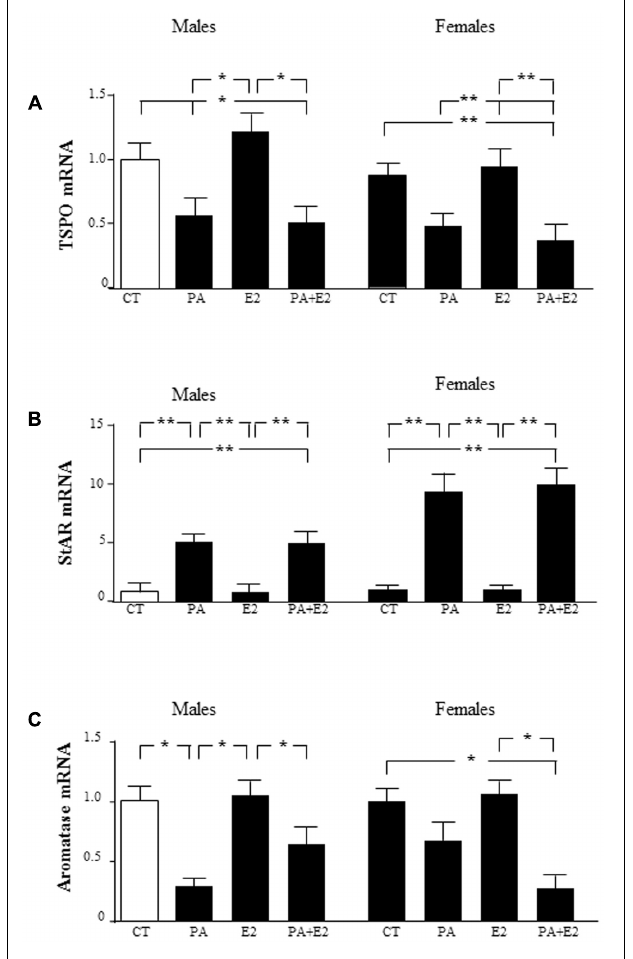
FIGURE 10 | Effects of PA and 17 β E2 on translocator protein (TSPO), steroidogenic acute regulatory protein (StAR), and aromatase mRNA levels. Astrocyte cultures were treated with PA (0.5 mM), E2 (10 − 10 M) or the combination of both. Relative mRNA levels of TSPO in males and females (A) ; StAR in males and females (B) ; and aromatase in males and females (C) . The average of three independent assays performed in duplicate is shown. Statistical significance: ∗ p < 0.05 and ∗∗ p < 0.01. FIGURE 11 | Effects of PA and 17